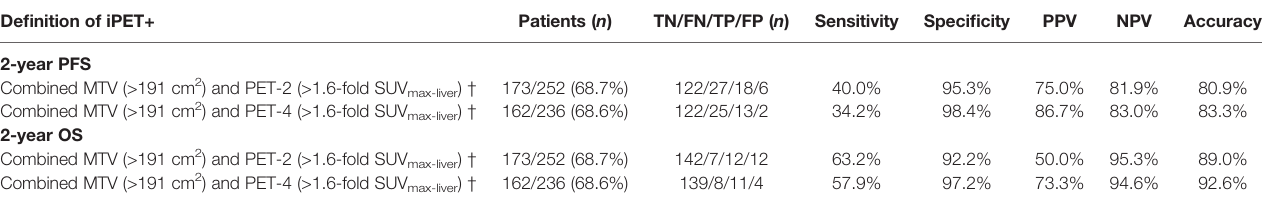
TABLE 4 | Accuracy of 18 F-FDG PET/CT interpreted using baseline metabolic tumor volume combined with the Peking criteria. De fi nition of